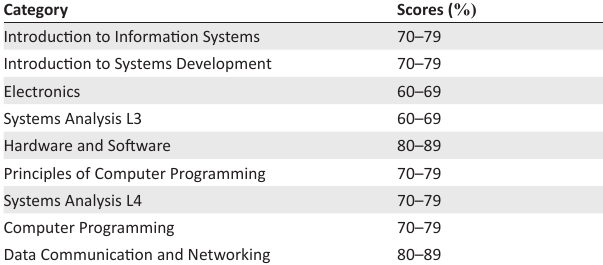
TABLE 2: The moderation scores before the knowledge portal